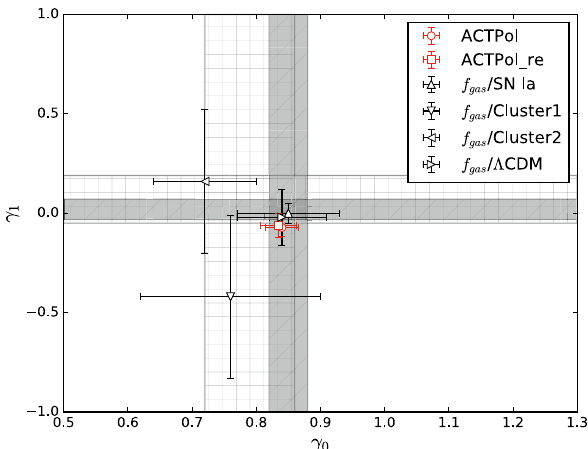
Fig. 6 Comparison of the best-fitted gas depletion factor parameters ( γ 0 ,γ 1 ). The red circle and square denote the best-fitted gas depletion factor within the cluster radius of R 500 , concerning the whole ACTPol and reduced ACTPol sample, respectively. The grey dashed and white netted region show the hydrodynamical simulation results (1 σ uncer- tainties) at different cluster radius ( R 500 and R 2500 ), while the triangles represent the best-fitted gas depletion factor parameters within R 2500 , given the same f gas sample and different distance